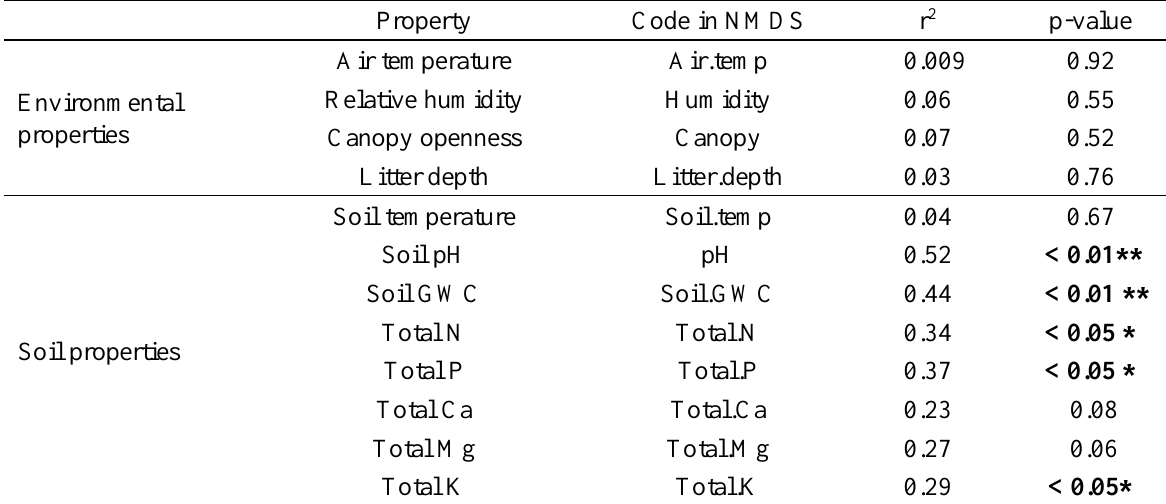
Table A2. Fits of environmental and soil properties onto NMDS ordination, based on presence-absence data using the Jaccard index, of woody seedlings across 22 plots from mixed peat-swamp forest (MSF, n = 4 plots) heath forest (HF, n = 6 plots), kerapah forest (KF, n = 6 plots), and Shorea albida peat-swamp forest (SAP, n = 6 plots). r 2 values indicate the correlation coefficient denoting the strength of the correlation with p-values assessed using 1000 permutations. Significant p-values (α = 0.05 level; * p < 0.05; ** p < 0.01; *** p < 0.001) are highlighted in